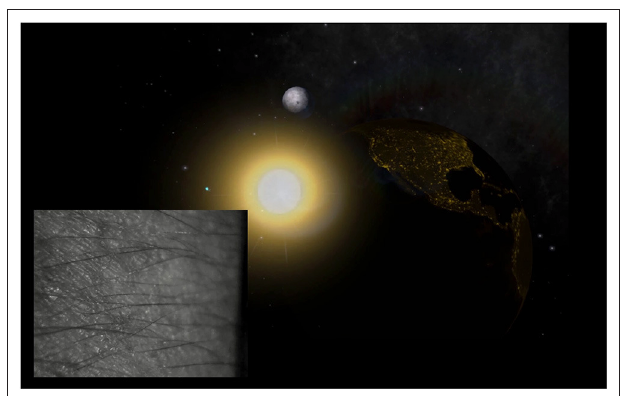
FIGURE 5 | The moment of shivers: aligned recording from the goosebump camera and screen recording from the HMD showing the Earth scene with the sun appearing from behind